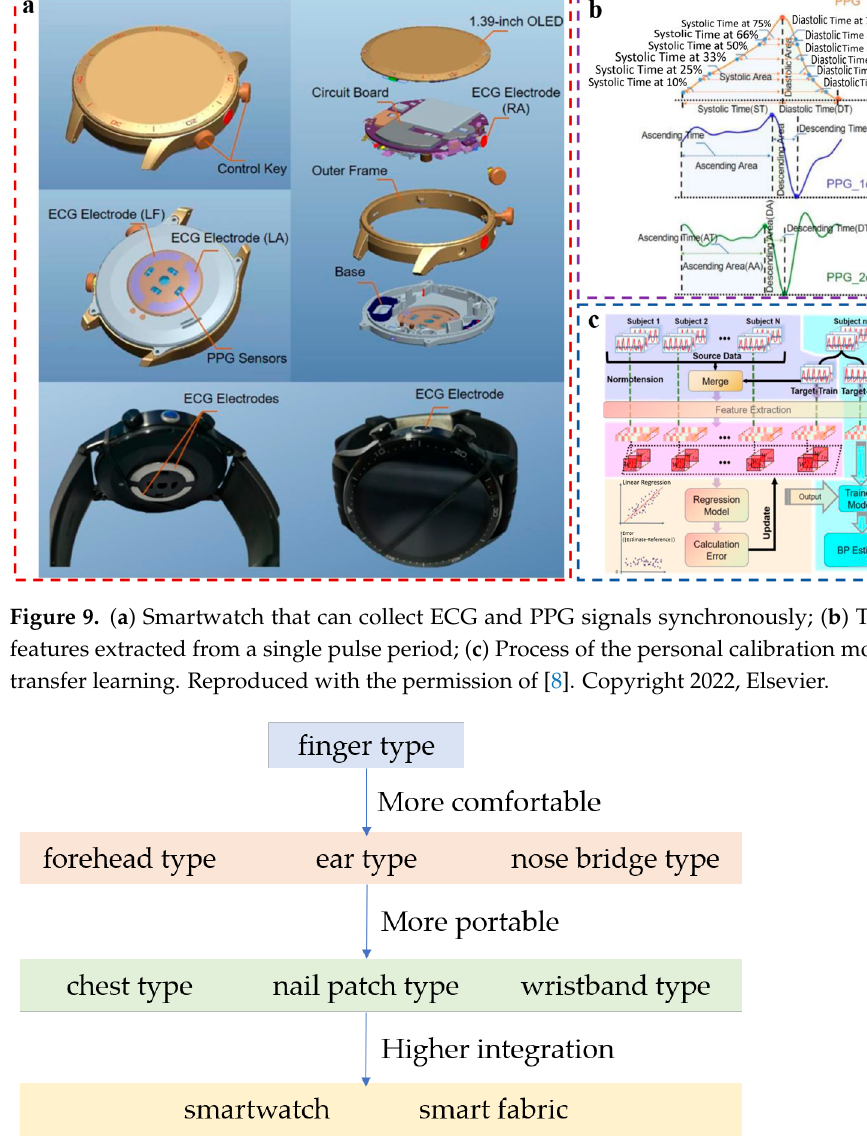
Figure 9. ( a ) Smartwatch that can collect ECG and PPG signals synchronously; ( b ) Time-domain features extracted from a single pulse period; ( c ) Process of the personal calibration mode based on transfer learning. Reproduced with the permission of [8]. Copyright 2022, Elsevier.